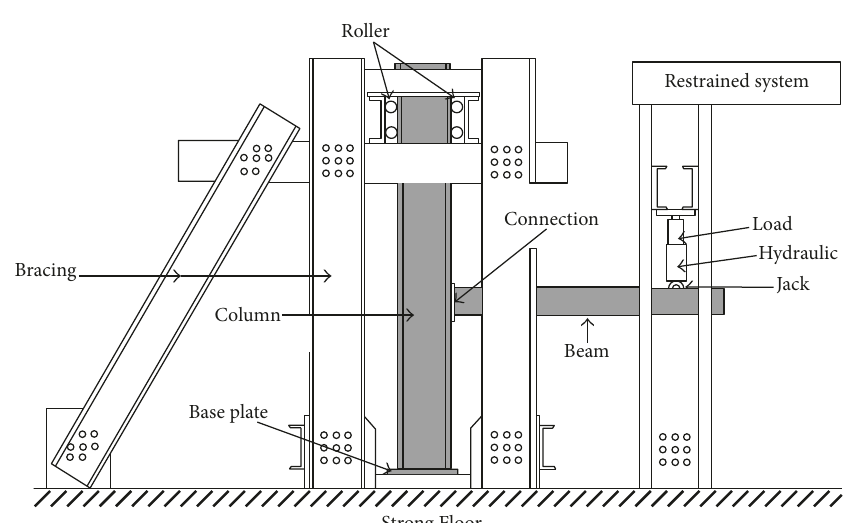
Figure 7: Test rig for full-scale